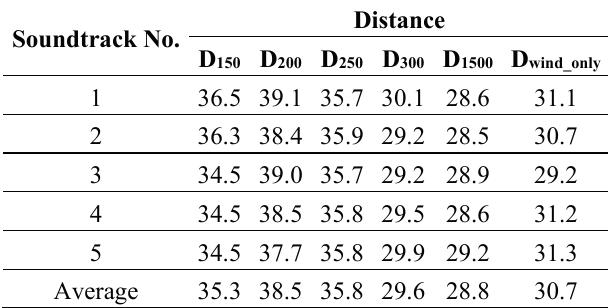
Table 1. Sound equivalent levels, in dB(A), for the 5 soundtracks at the six distances. Soundtrack